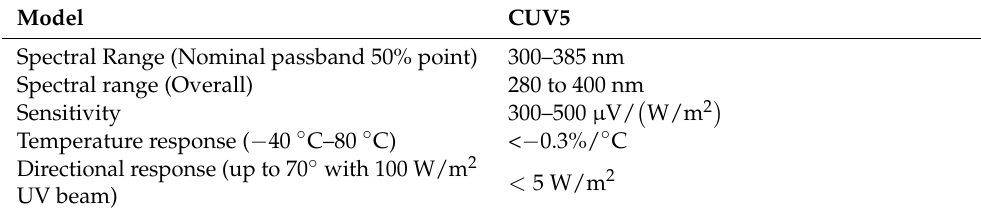
Figure 1. Location of the experimental equipment on the roof of the Higher Polytechnic School building at the University of Burgos (Spain). Table 2. UV Radiometer technical specifications.